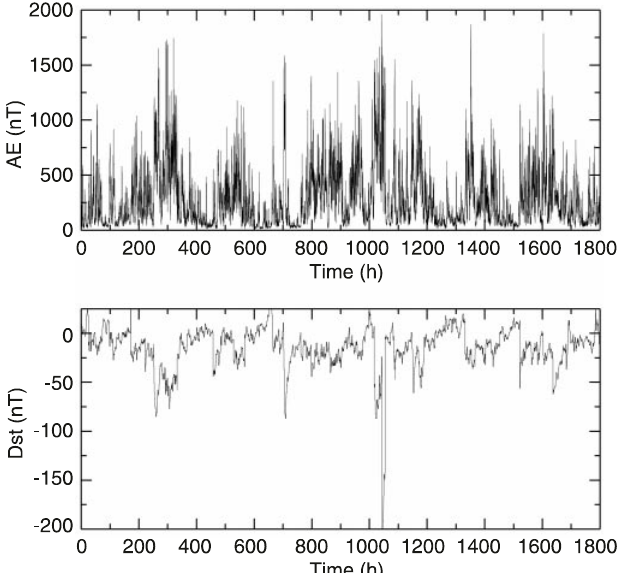
Fig. 3. Observed and predicted AE based on 100 min of solar-wind parameters n , V , B y , and B z . This particular interval started on the morning of 2 March 1974 (08.10 UT), and ended two days later on 4 March 1974